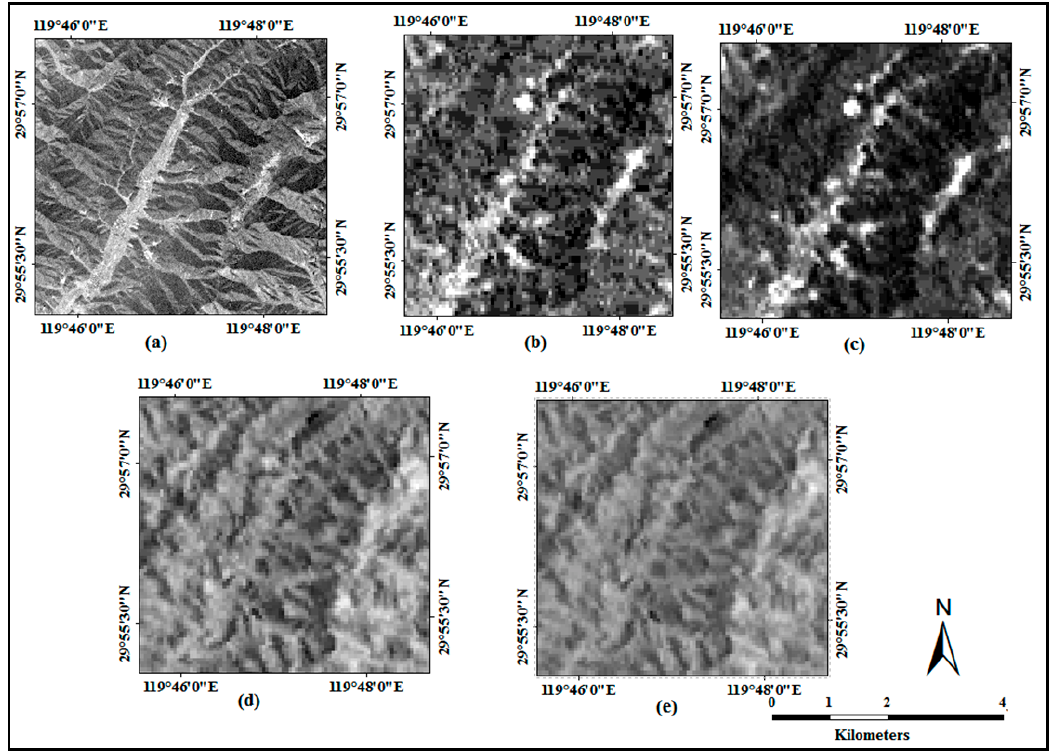
Figure 10. Visual difference between CORONA panchromatic image and Landsat MSS bands; ( a ) CORONA; ( b ) Landsat MSS4 (Green band); ( c ) Landsat MSS5 (Red band); ( d ) Landsat MSS6 (NIR1 band); and ( e ) Landsat MSS7 (NIR2 band ).